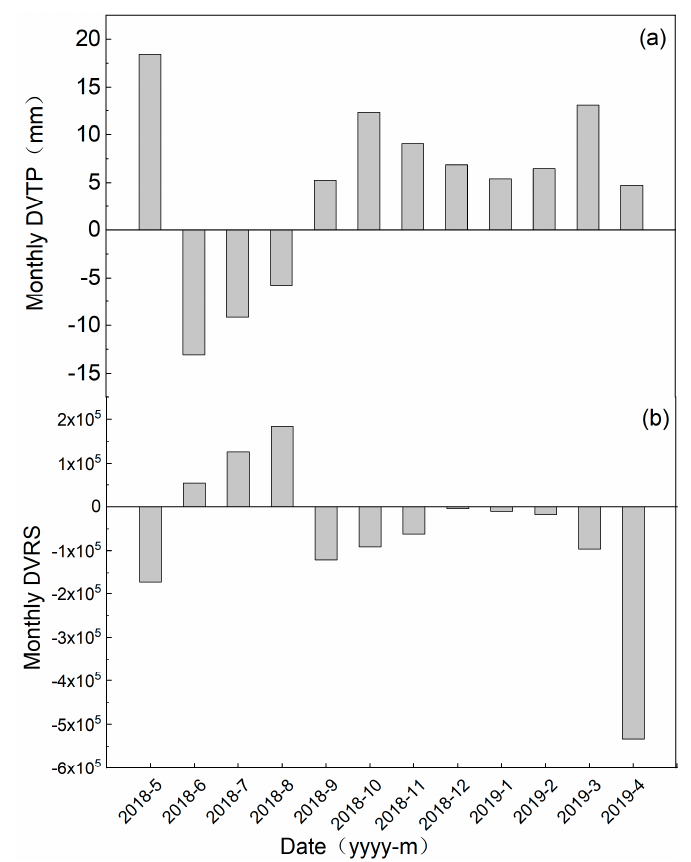
Figure 4. The variations of monthly difference value of precipitation amount recorded by Geonor T-200B and PWS100 (DVTP) ( a ); and monthly difference value between rain and snow particles (DVRS) from 1 May 2018 to 30 April 2019 ( b ).